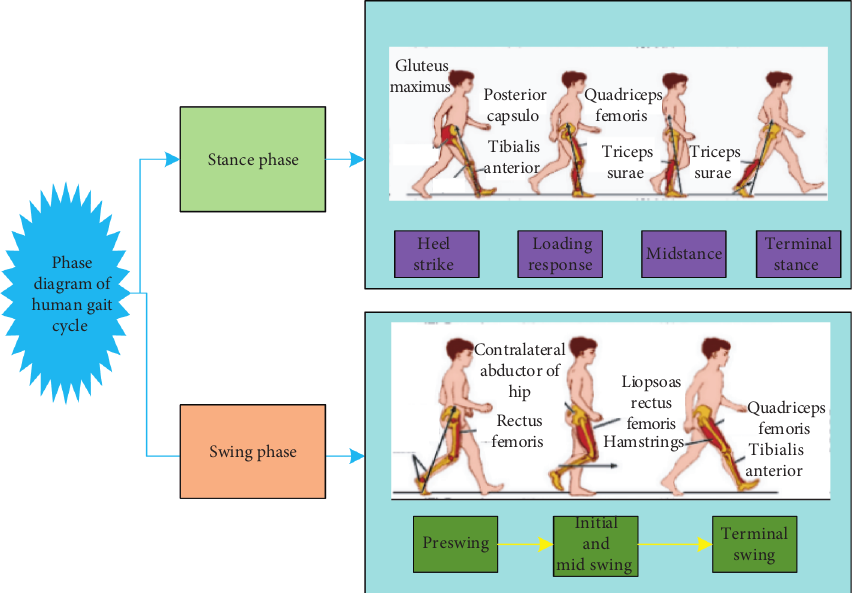
Figure 1: Phase diagram of human gait